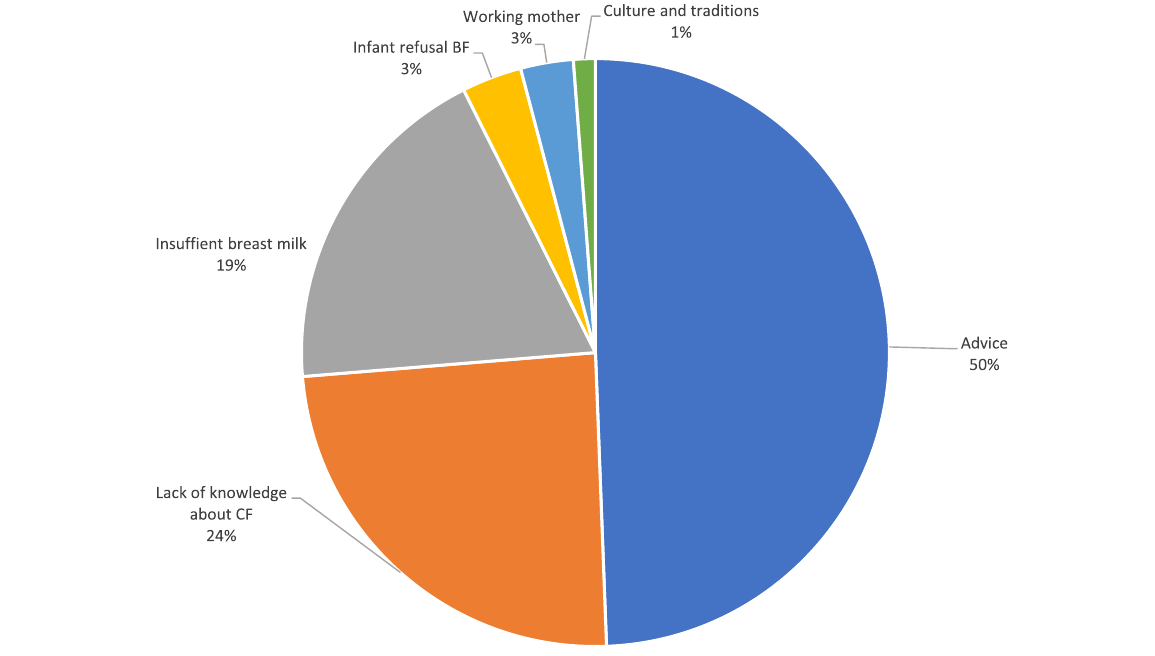
Fig. 1 Distribution of reported reasons for starting of CF introduction